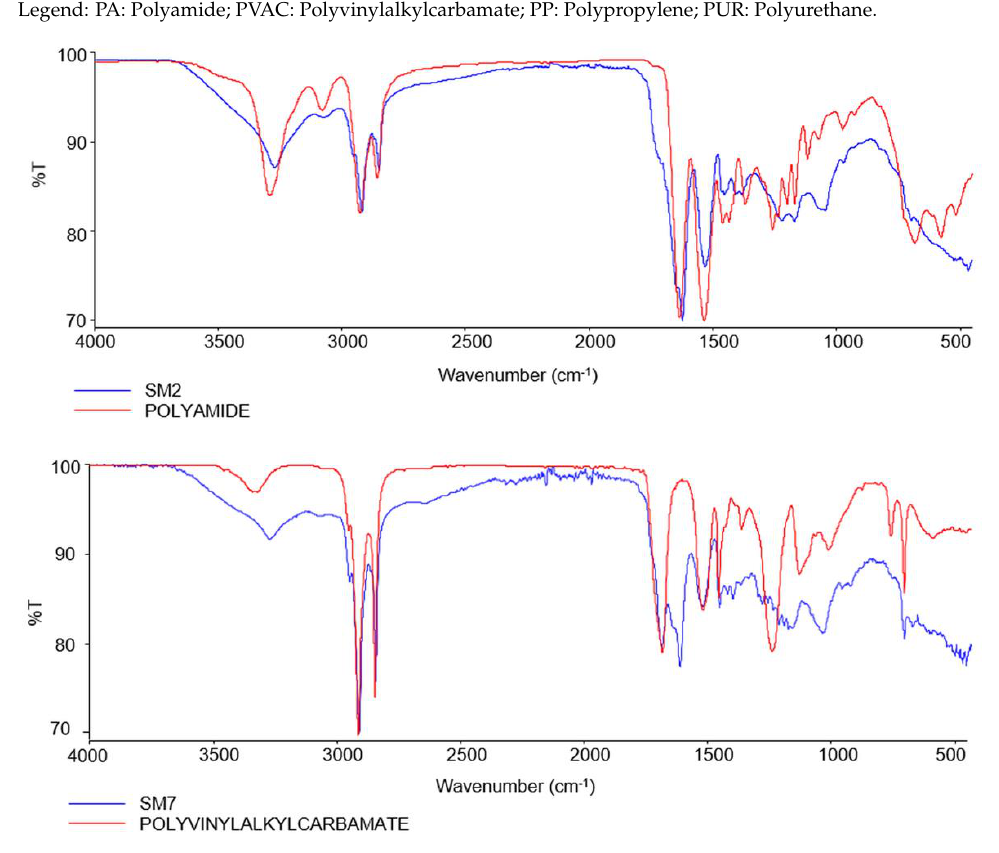
Figure 3. spectra resulting from FTIR-ATR analysis of samples SM2 and